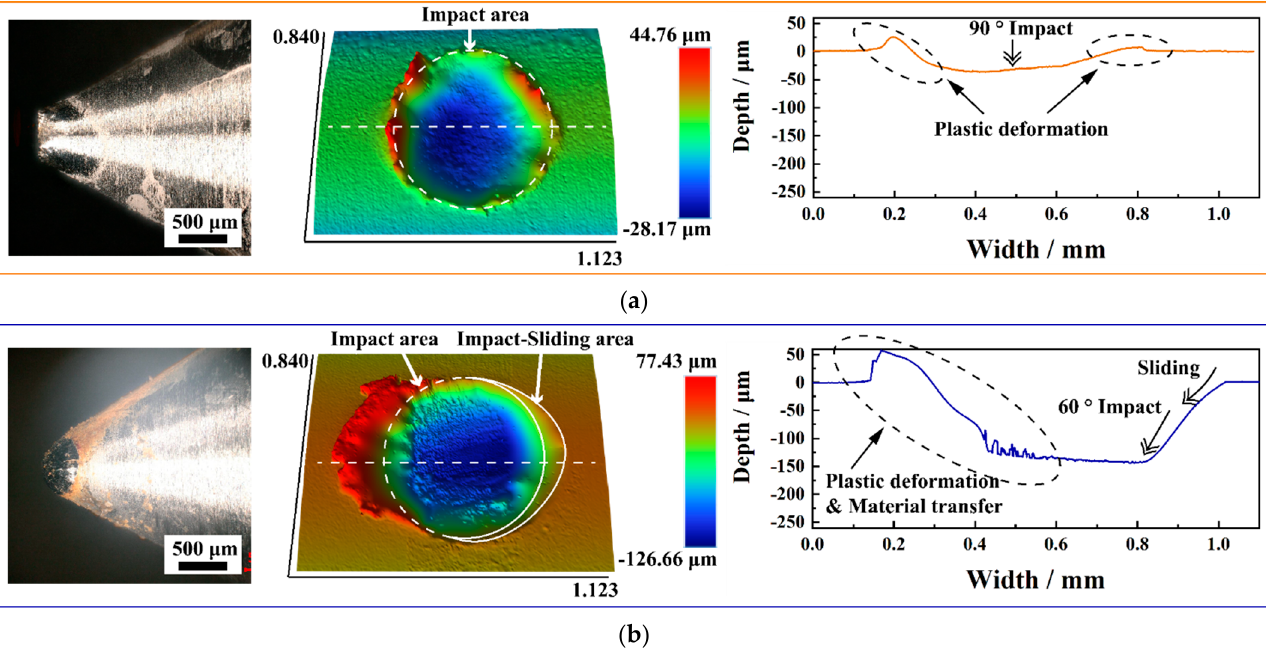
( c ) Figure 10. Wear of impact blocks and tube specimens at different impact angles. ( a ) θ = 90°; ( b ) θ = 60°; ( c ) θ = 45°. Figure 10a shows high bulges around the θ = 90° impact worn scar; however, in Fig- ure 10b–c, the protrusions of θ = 60° and θ = 45° impact worn scar edge only occur at the edge of the circular impact area on the left, and no evident bulges are found at the edge of the elliptical impact-sliding area. Moreover, the sectional profiles of the impact-sliding area of the θ = 45° impact worn scar is rough, and a large amount of material wear removal is found. Figure 11 shows the statistics of the maximum wear depth, wear area, wear volume, and wear rate of the Zr-4 alloy tube caused by different impact angles. With the inclination of the impact angle, the maximum wear depth, wear area, wear volume, and wear rate increase, and the wear rate of θ = 45° impact with the most energy loss in the impact- sliding stage is much higher than θ = 90° and θ = 60°. This phenomenon shows that the impact-sliding stage is more likely to cause material damage than the impact stage.